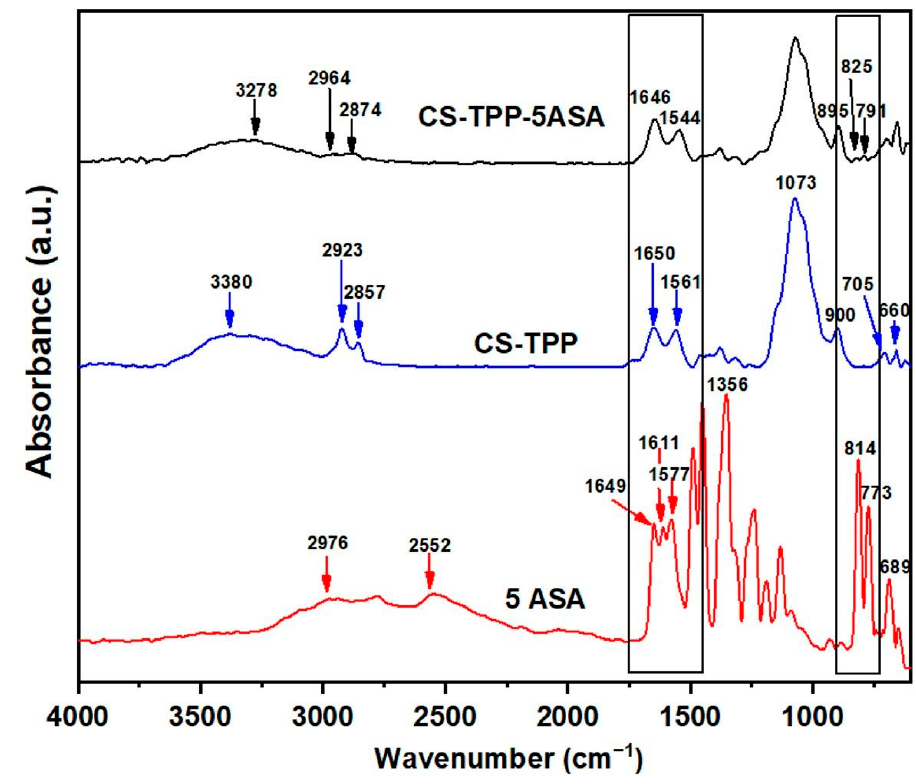
Figure 2. FT-IR spectra of neat and drug loaded CS-TPP hydrogel beads and